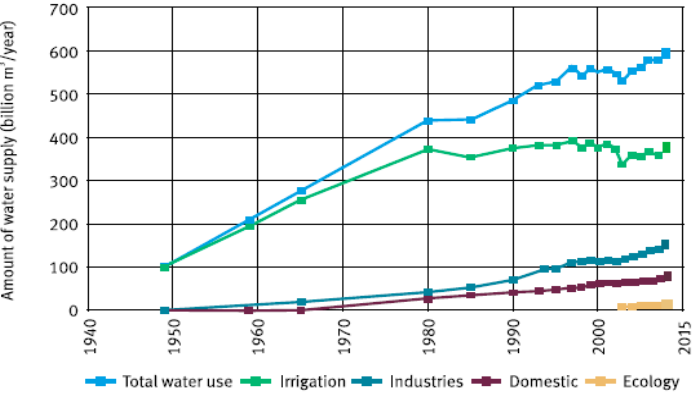
Figure 1. Increasing water use in China. Data source: China Water Resources Bulletin (1997–2000) and China Statistical Yearbook (2000–2015).